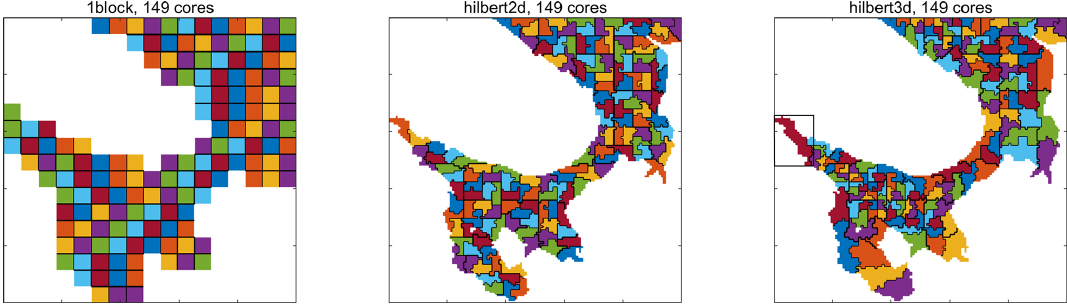
Figure 2. Three types of partition. Different processor cores are separated by a black line. Hilbert partitions are based on a grid of n b × n b = 128 × 128 blocks. Colors can repeat. The black rectangle in the figure for the hilbert3d partition corresponds to a “shared” array allocated for blocks belonging to a given CPU